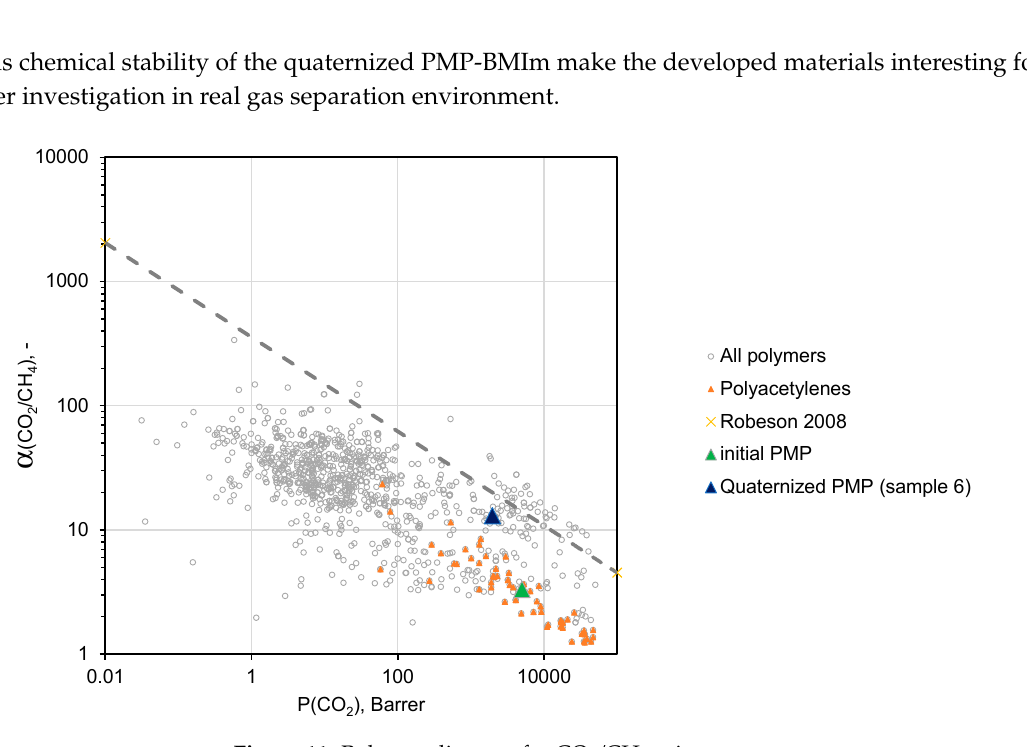
Figure 10. Robeson diagram for CO 2 /N 2 mixtures.